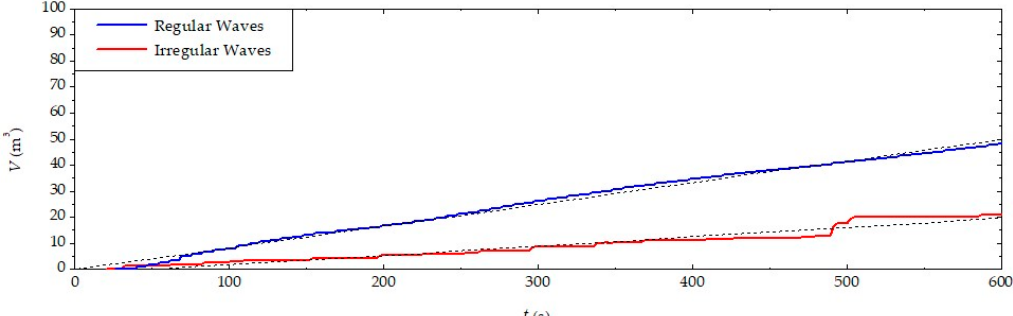
Figure 18. Volume of water accumulated in the reservoir over time due to the incidence of the representative regular waves and realistic irregular waves for TV.